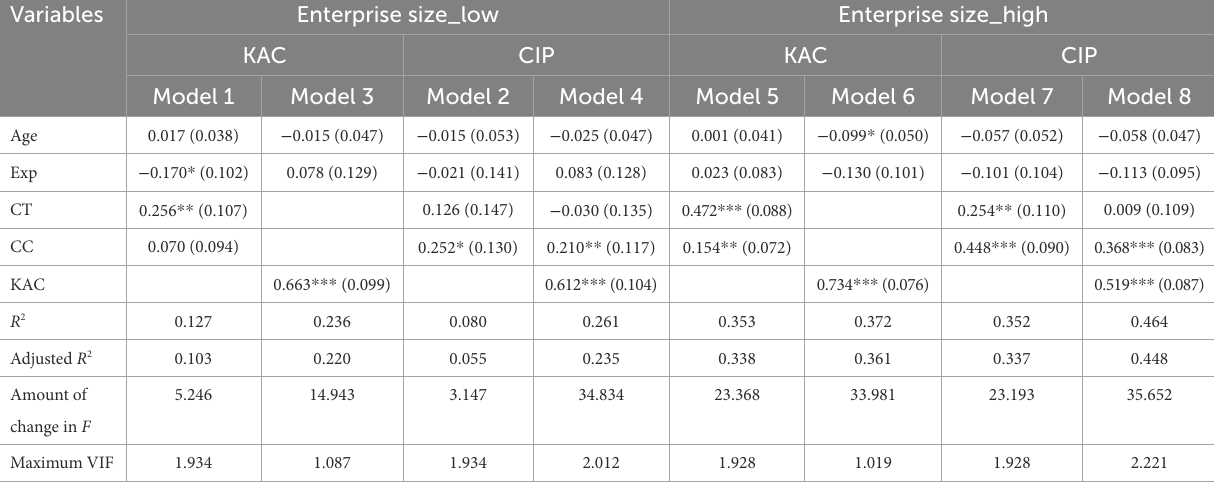
TABLE 6 Heterogeneity analysis of the enterprise scale.